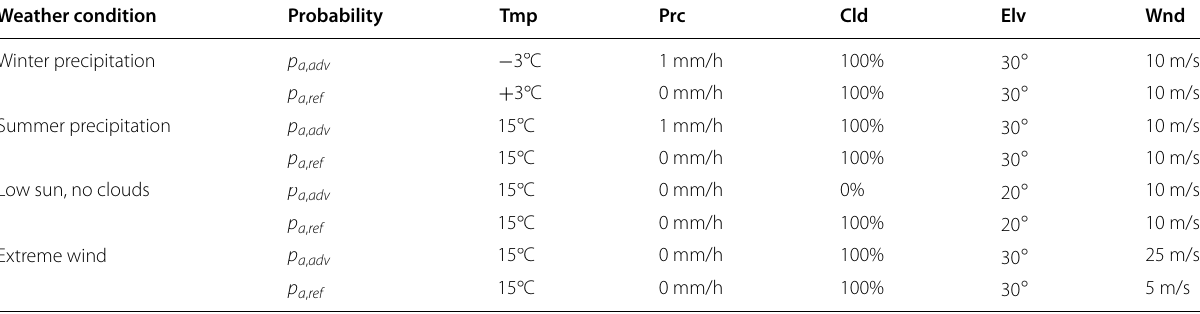
Table 3 Setup of meteorological parameters for calculation of relative risk increase for different meteorological conditions. p a , adv and p a , ref is the crash probability under adverse and reference conditions, respectively. In all cases, Yr = 2017 , Trf = 1 and ¯ p a , d is set to the median value of all